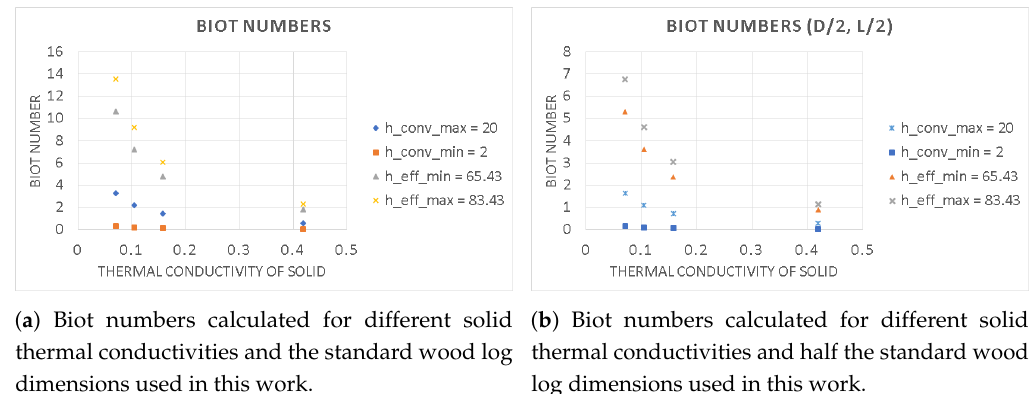
Figure 2. Importance of accurate modeling of temperature gradients in thermally thick wood